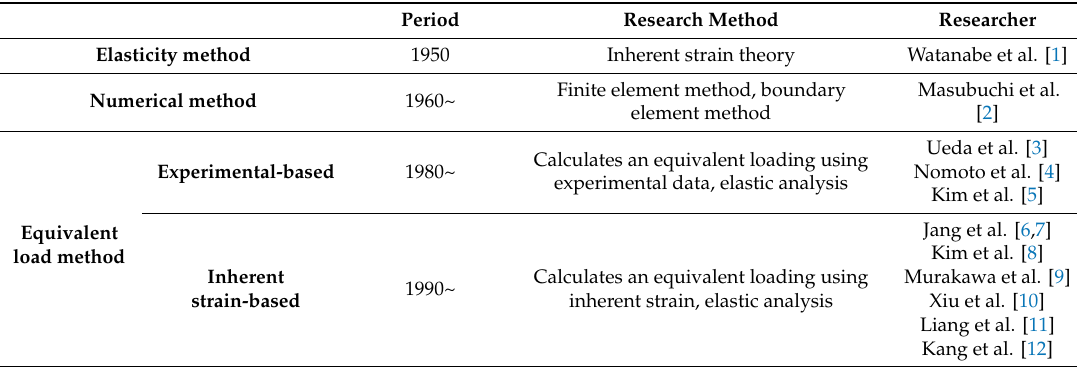
Table 1. Methodologies of welding deformation